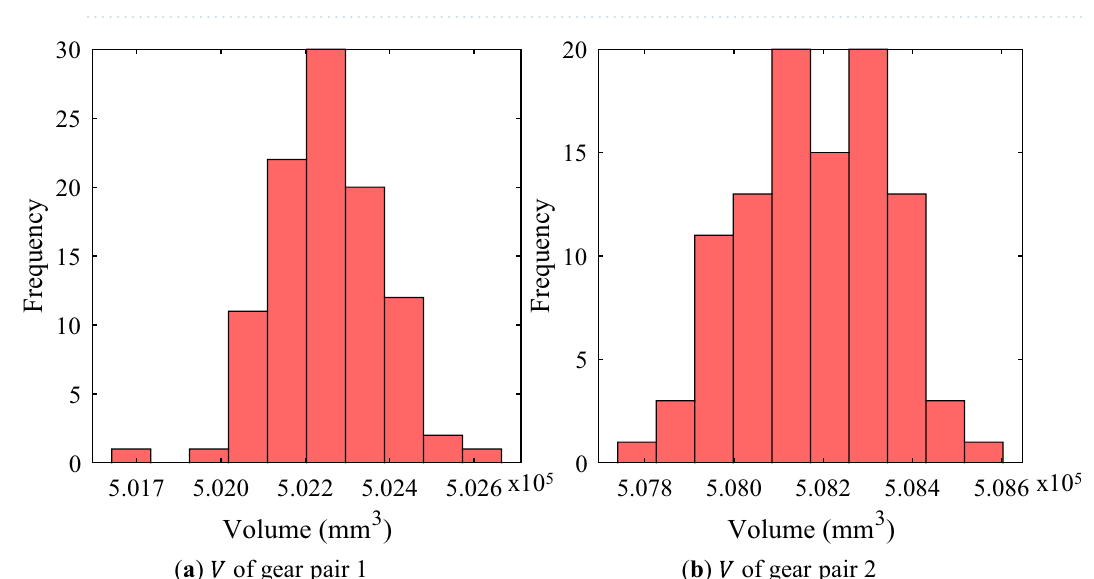
Figure 4. Frequency distribution of mass of each gear pair using random robustness analysis.